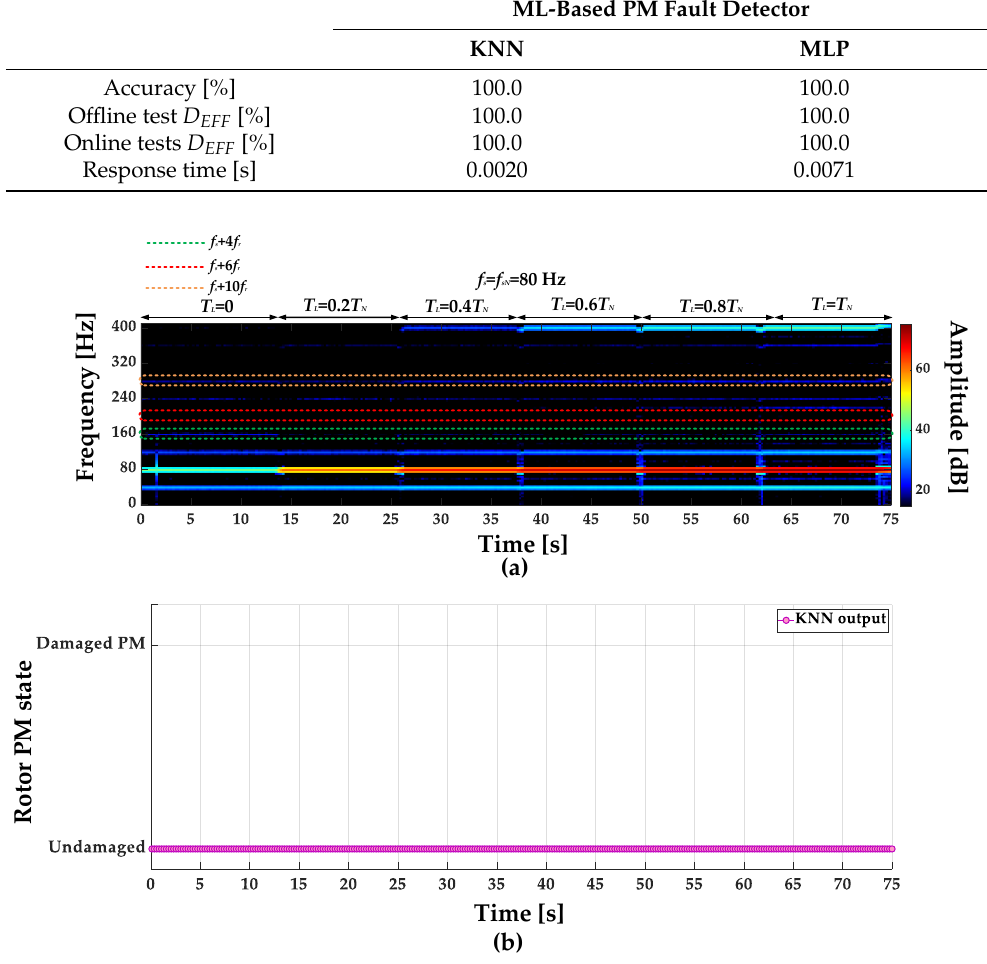
Figure 17. ( a ) Part of the stator phase current STFT spectrogram, ( b ) response of the KNN-based fault detector for undamaged rotor ( T L = var, f s = 80 Hz).